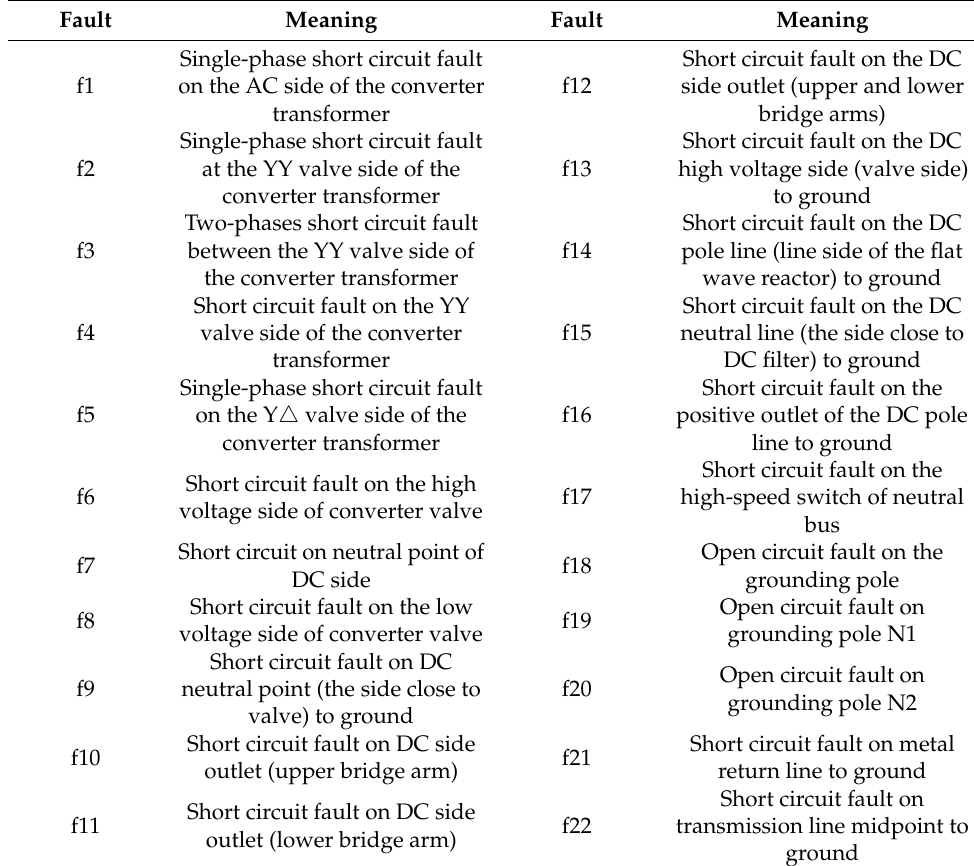
Table 4. The marks and descriptions of 22 typical fault